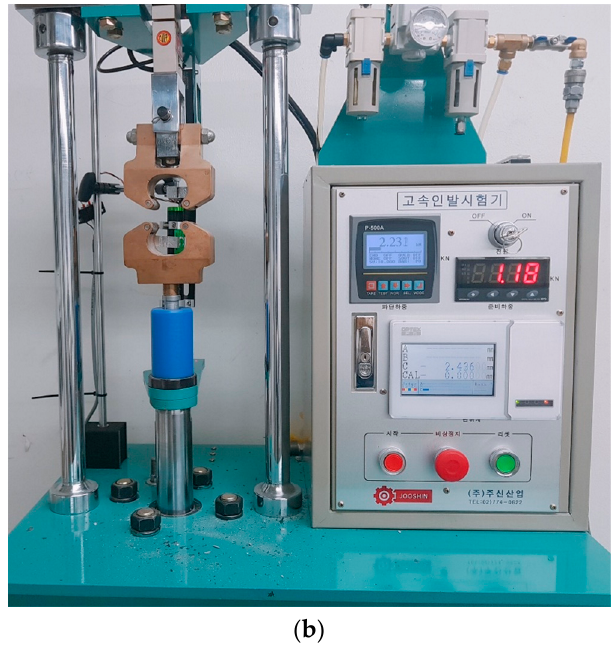
Figure 3. Fiber pullout impact test machine: ( a ) schematic description and ( b ) picture.